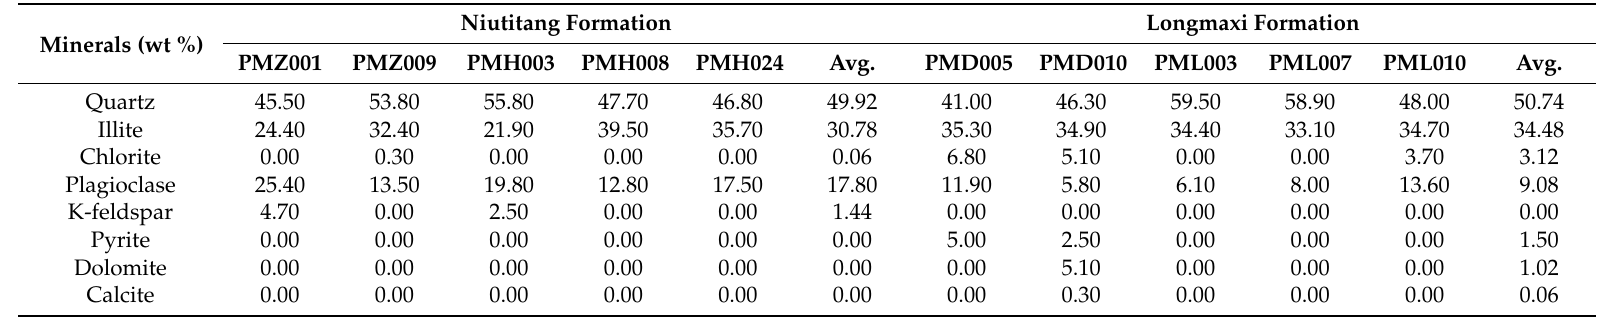
Table 1. The mineral content of the shale